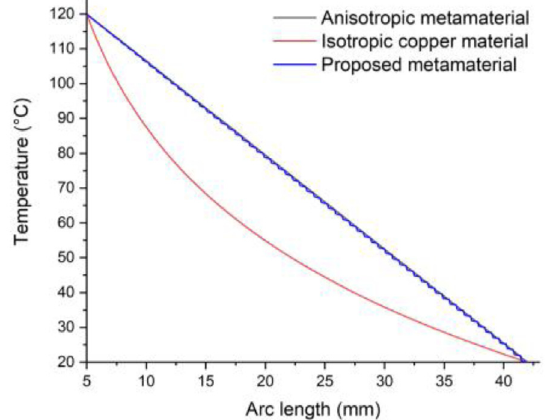
Fig. 8. Temperature gradient for an anisotropic metamaterial (black), isotropic copper (red) and the proposed